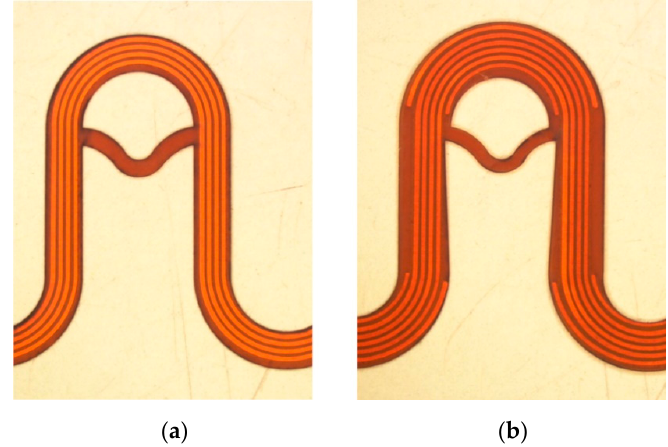
Figure 4. ( a ): Meander type 1 close-up. ( b ): Meander type 1-1 close up.